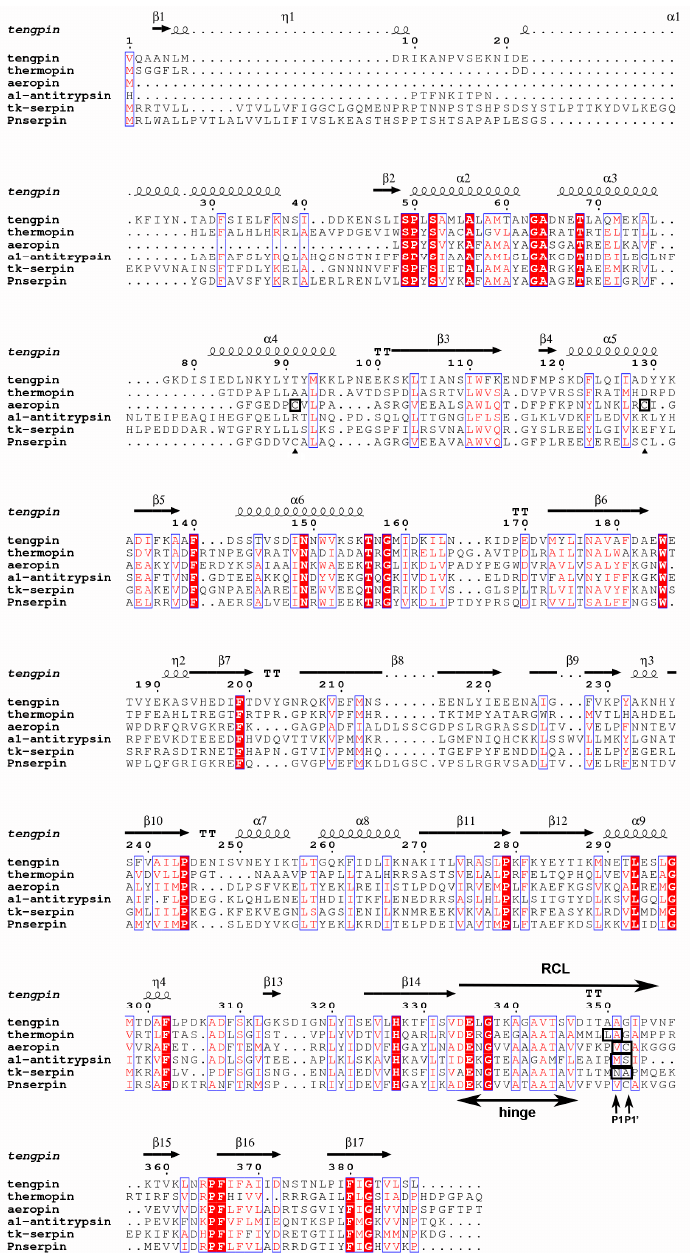
Figure 1. Multiple sequence alignment of serpin sequences. The amino acid sequence of Pnserpin is compared with those of α 1-antitrypsin, thermopin, aeropin, tengpin, and Tk-serpin. The highly conserved amino acid residues, which are conserved in >70% of the members of the serpin superfamily, are highlighted in red letters. The residues conserved in 100% are highlighted in red background. The conserved hinge region, the possible P1 and P1’ sites and the reactive center loop (RCL) region are indicated by arrows. The P1–P1’ positions in RCL, which have been reported, are in black boxes. The Cys102–Cys136 of aeropin is in blue boxes, and the corresponding residues of Pnserpin are indicated by a triangle. The figure was produced using ESPript3.0